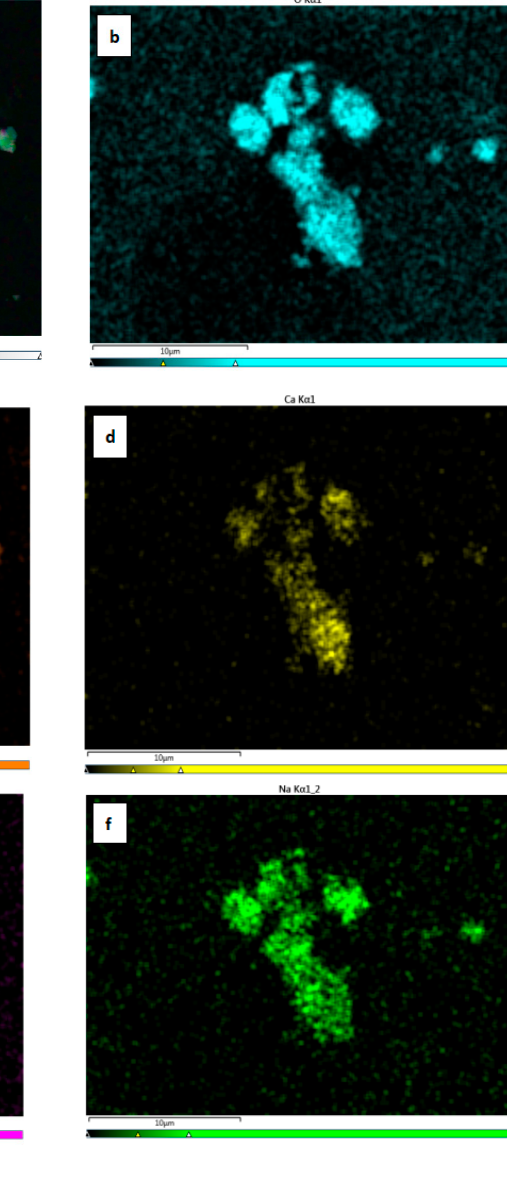
Figure 15. Element distribution diagram and EDS spectrum of SS14. ( a ) General distribution of ma- jor elements, ( b ) O element, ( c ) Si element, ( d ) Al element, ( e ) Na element, ( f ) Ca element, ( g ) Mg element, ( h ) EDS spectrum.